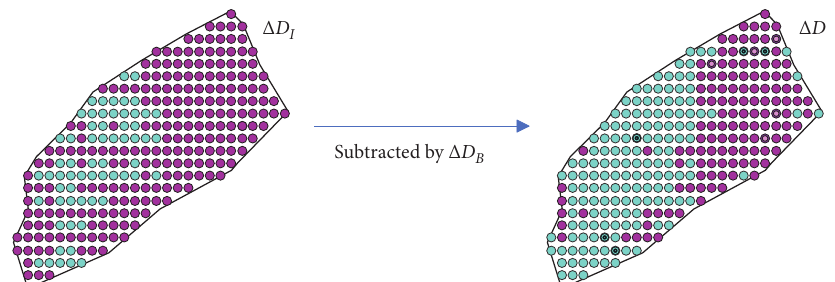
Figure 4: Change of the difference between the pre- and postearthquake DEM after correction. Purple dots represent net gain places and blue dots represent net loss